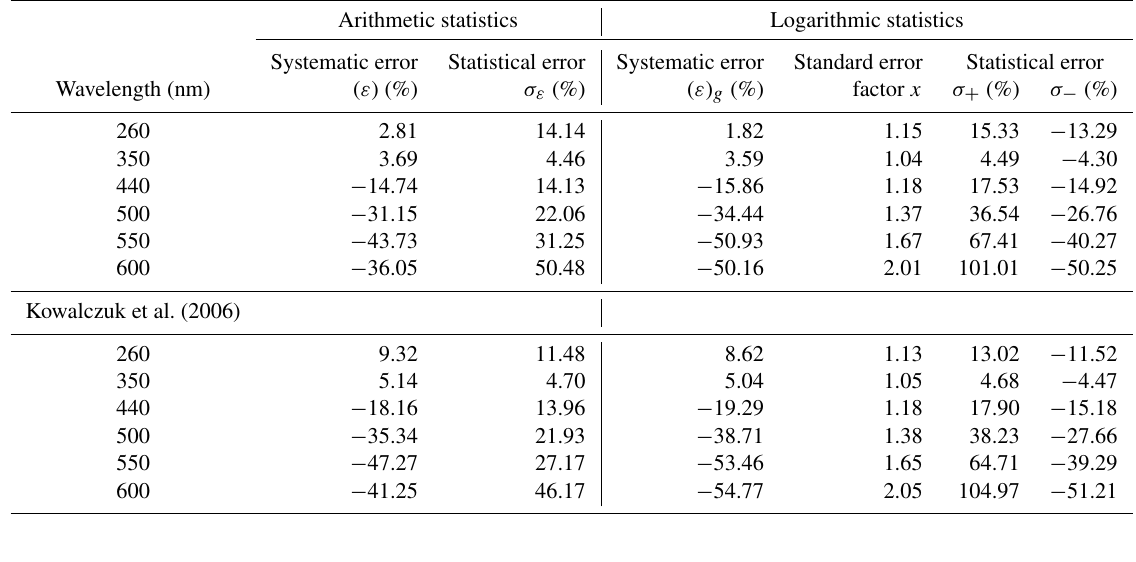
Table 5. Relative errors of the empirical models given by Eqs. (15) and (1) for determining spectral values of CDOM absorption coefficients ( a CDOM (λ)) at selected wavelengths.